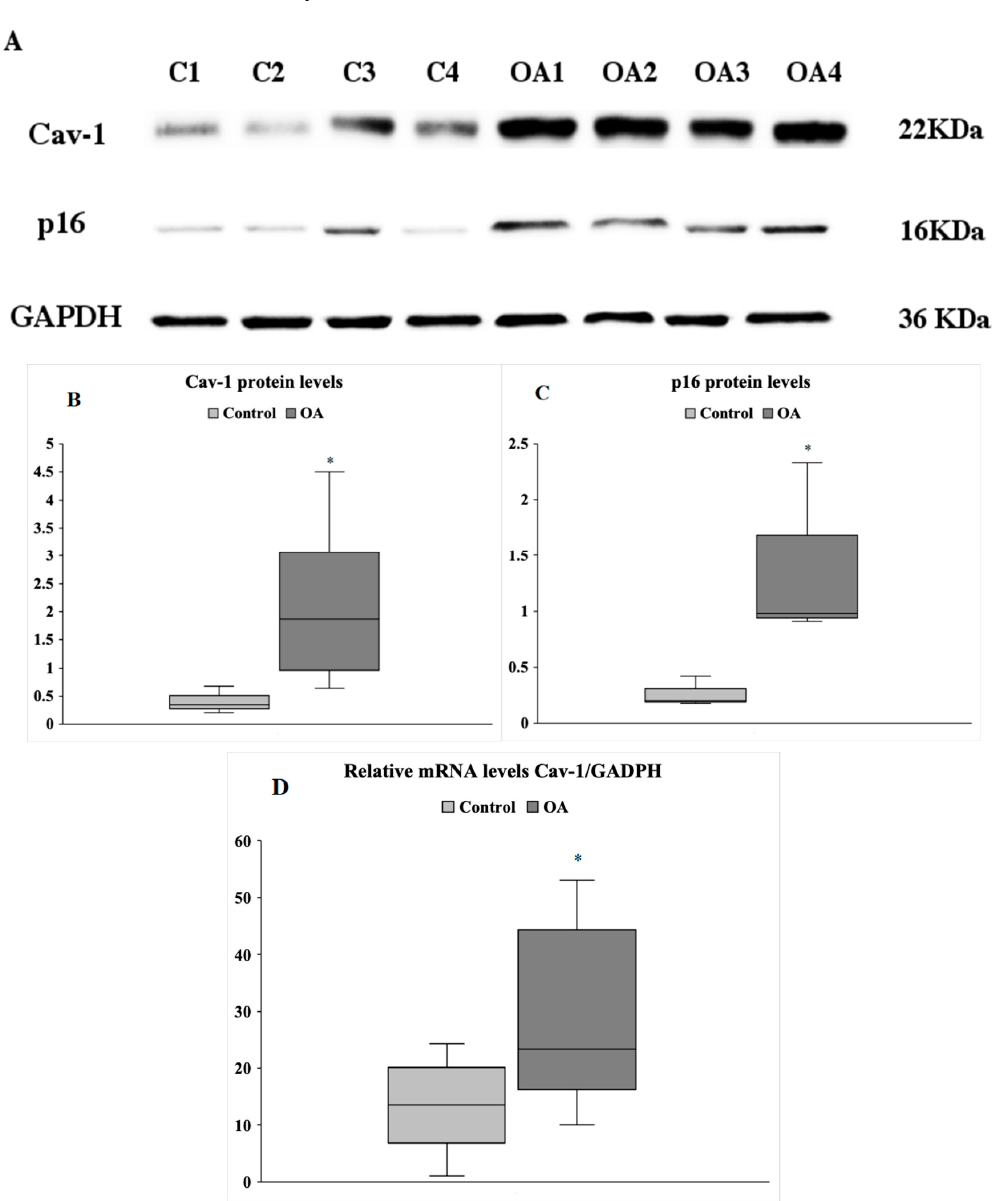
Figure 1. ( A ) Caveolin-1 levels are significantly higher in osteoarthritic (OA) than in control chondrocytes under normal conditions . Characteristic blot showing caveolin-1(Cav-1) and p16 levels in four control and four OA chondrocytes lysates. GAPDH was used as loading control. ( B ) Box blot demonstrating quantification of relative protein expression levels of caveolin-1 in cell lysates from 13 control and 17 OA patients samples was performed based on band density using Image J. ( C ) Box blot demonstrating quantification of relative protein expression levels of p16 in cell lysates from 13 control and 17 OA patients samples was performed based on band density using ImageJ. Values shown are the means ± S.E. * p < 0.05 versus control. ( D ) Box blot demonstrating quantification of relative mRNA levels of caveolin-1 in control and OA chondrocytes. The horizontal lines inside the boxes denote the medians and the horizontal borders of the boxes the interval between 25th and 75th percentiles. The whiskers show the minimal and maximal values. Analysis was performed using chondrocytes from 13 healthy donors and 17 OA patients. * p < 0.05 versus control. p values were calculated using the Mann–Whitney U test.